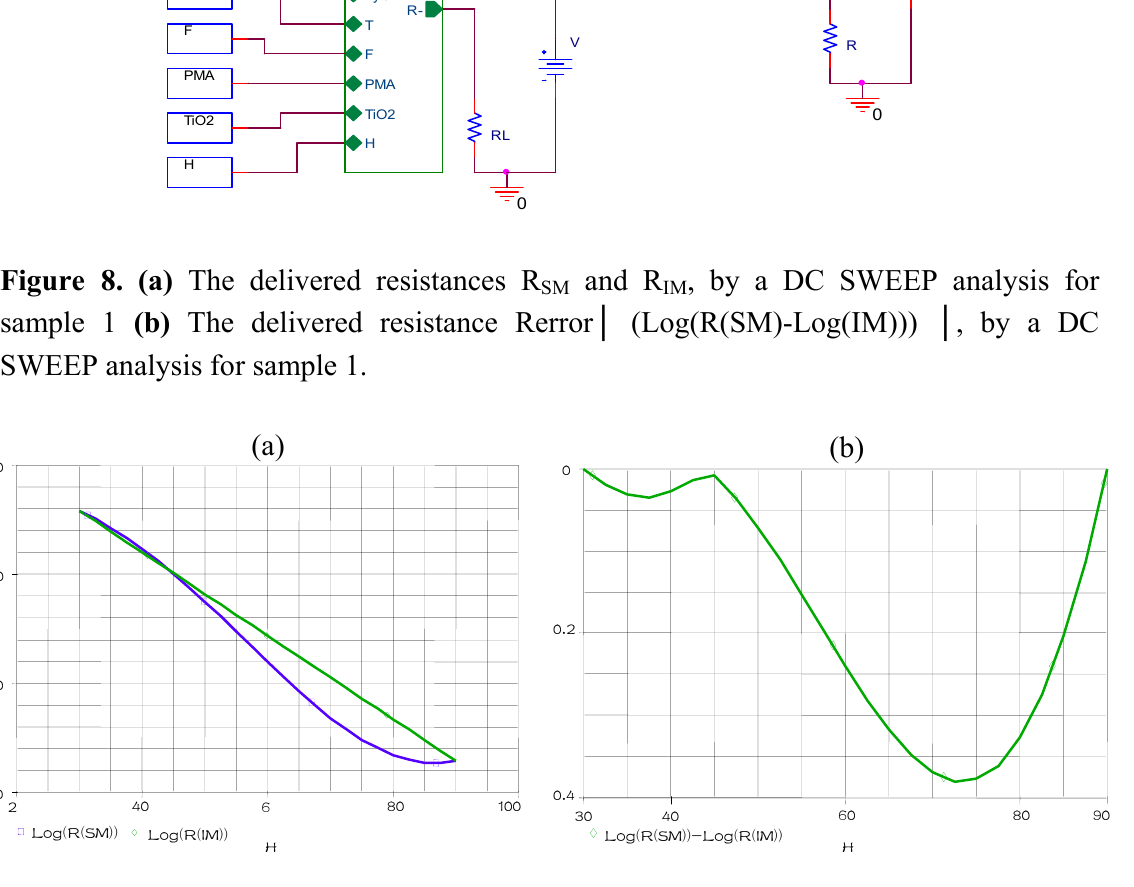
and R , by a DC SWEEP analysis for SM IM